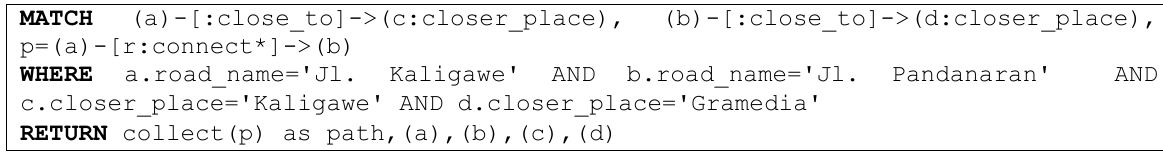
Fig. 10. Query for searching multimodal transportation and closer path in origin and destination